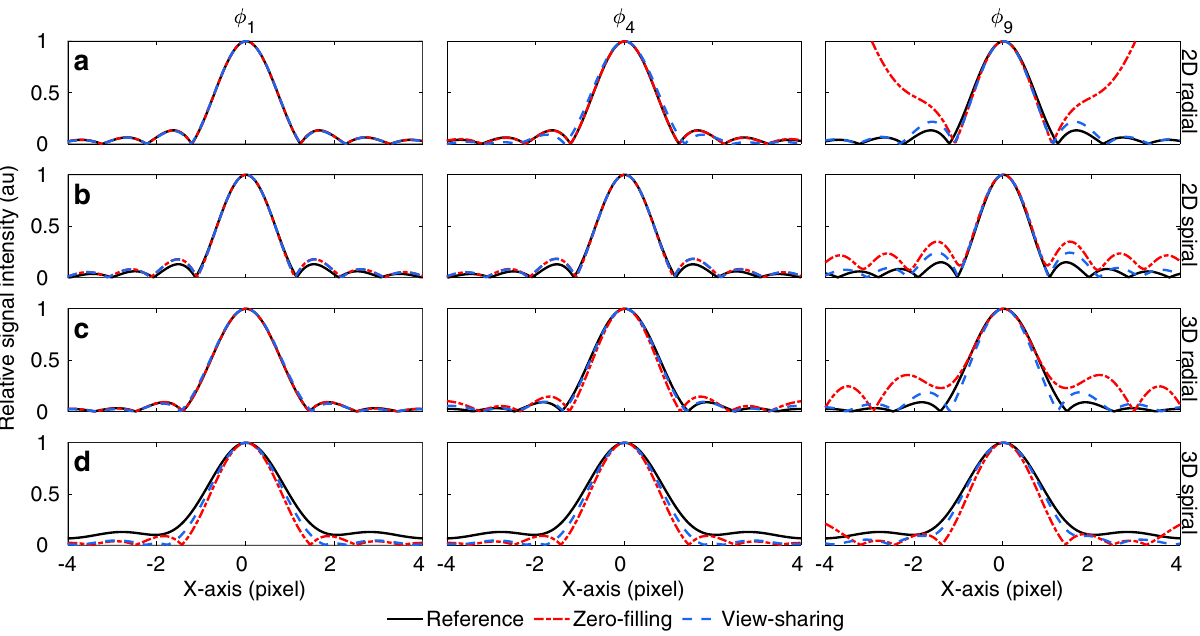
Figure 6. Point spread function analysis. The PSF analysis evidences that view-sharing reconstruction is beneficial when considering lower energy SVD coefficients. Without view-sharing, the PSF will have increased sidelobes for all trajectories, most notably in 2D and 3D radials. φ n represents the n-th SVD coefficient.